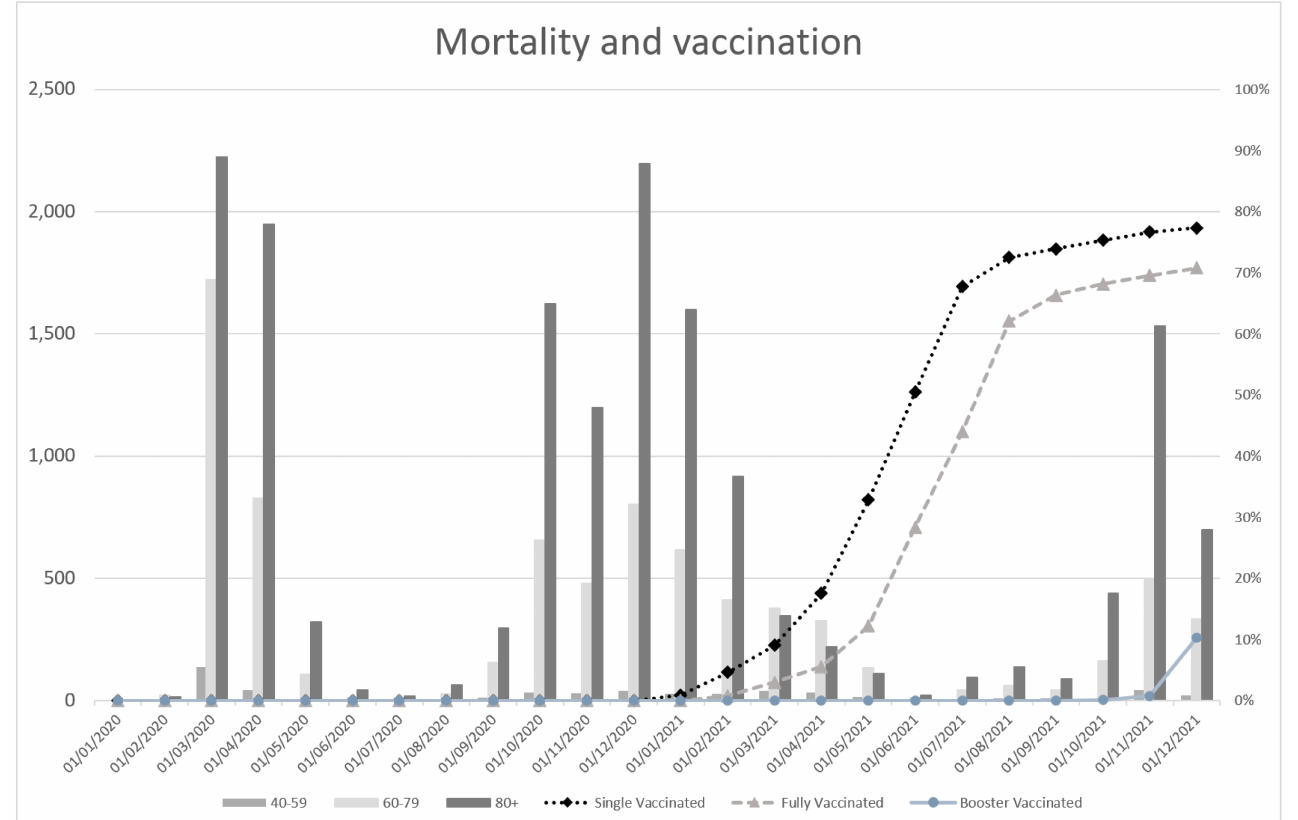
Figure 3. Total mortality and vaccination rate over time. The mortality in the Netherlands over time is displayed using bar graphs. The vaccination level over time relative to the overall Dutch population is shown using the line